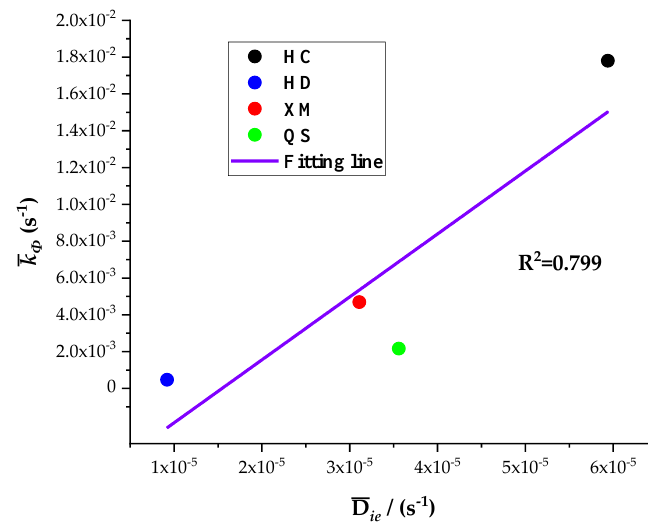
Figure 11. The linear regression of k Φ on D ie.